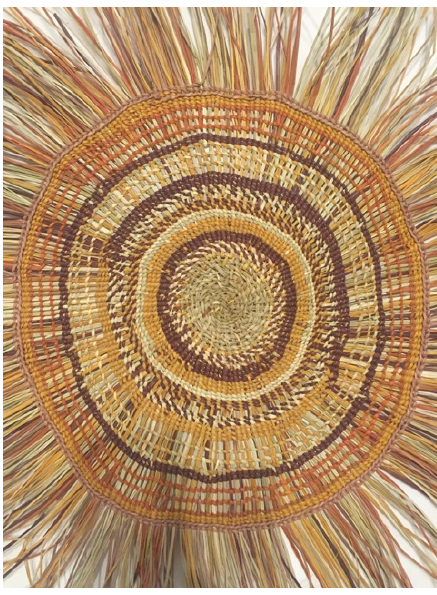
Figure 1. Woven mat by Banbapuy.